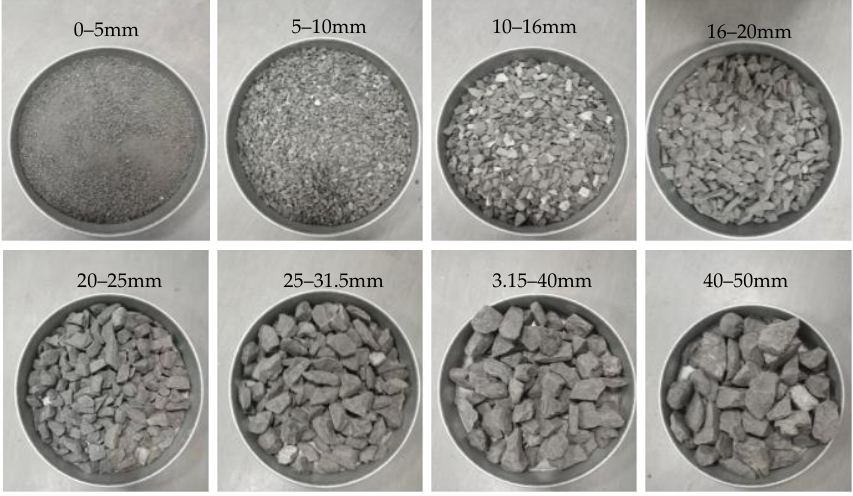
Figure 29. Photos of gangue with different grain sizes [107].